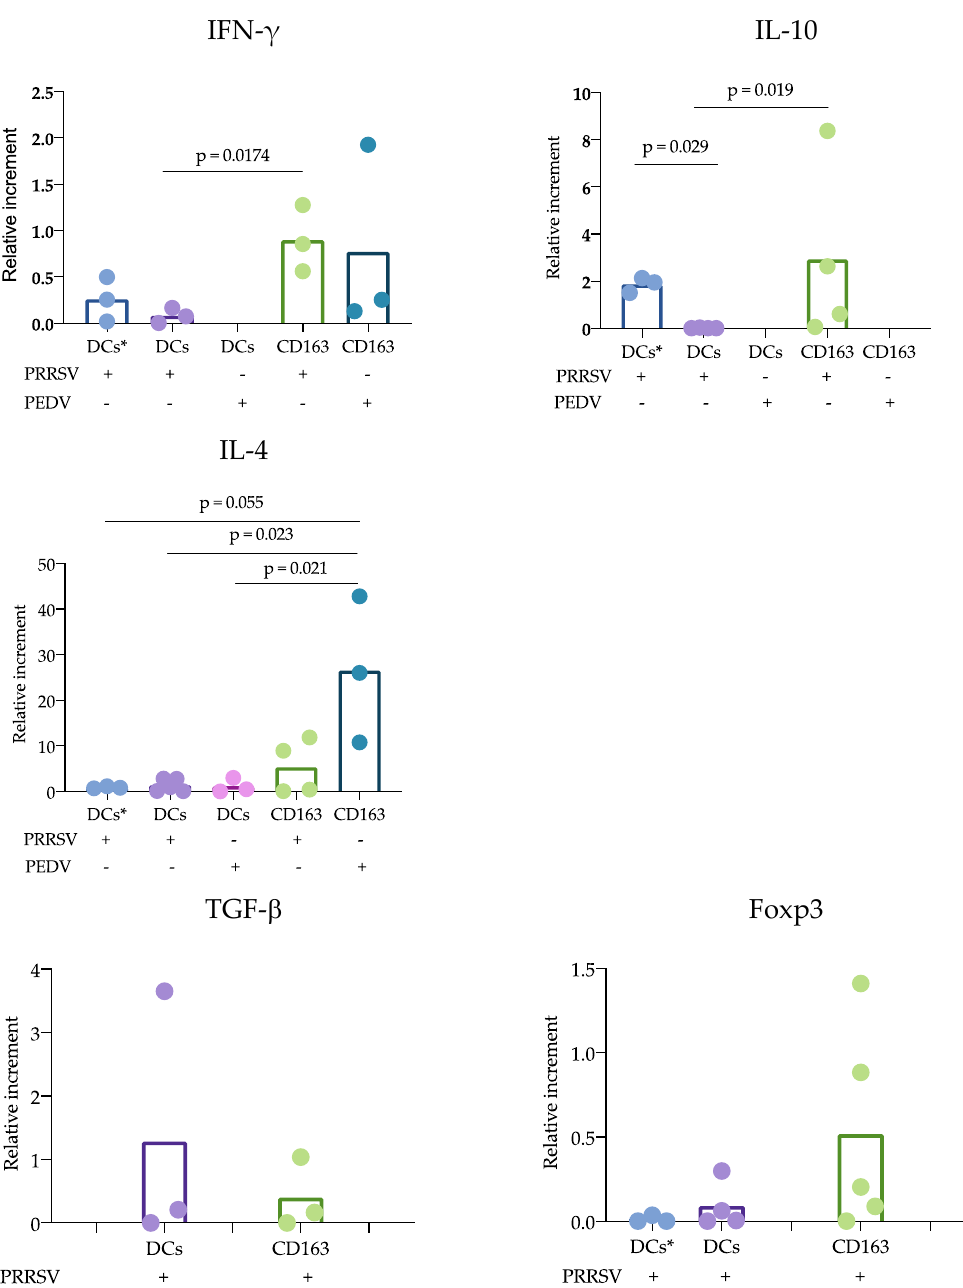
Figure 4. Cytokine expression in cocultures of antigen-presenting cells (APCs) with autologous naïve CD3 + cells. Blood cDCs, splenic cDCs or CD163 + cells were cocultured with naïve CD3 + cells for 24 h, and cytokine expression was evaluated by qPCR. The results were analyzed with the 2 − ∆∆ Ct method and are presented as relative increments. In each figure, the bars represent the mean, and each point represents one pig. Data were analyzed with the nonparametric Kruskal-Wallis test (IFN- γ , IL-10, IL-4 and Foxp3) or the Mann-Whitney (TGF- γ ) test. Significant di ff erences are indicated. DCs *, blood cDCs.